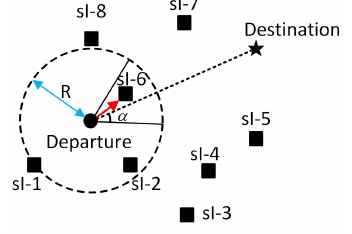
Figure 2. Example of NSI-path planning from departure to